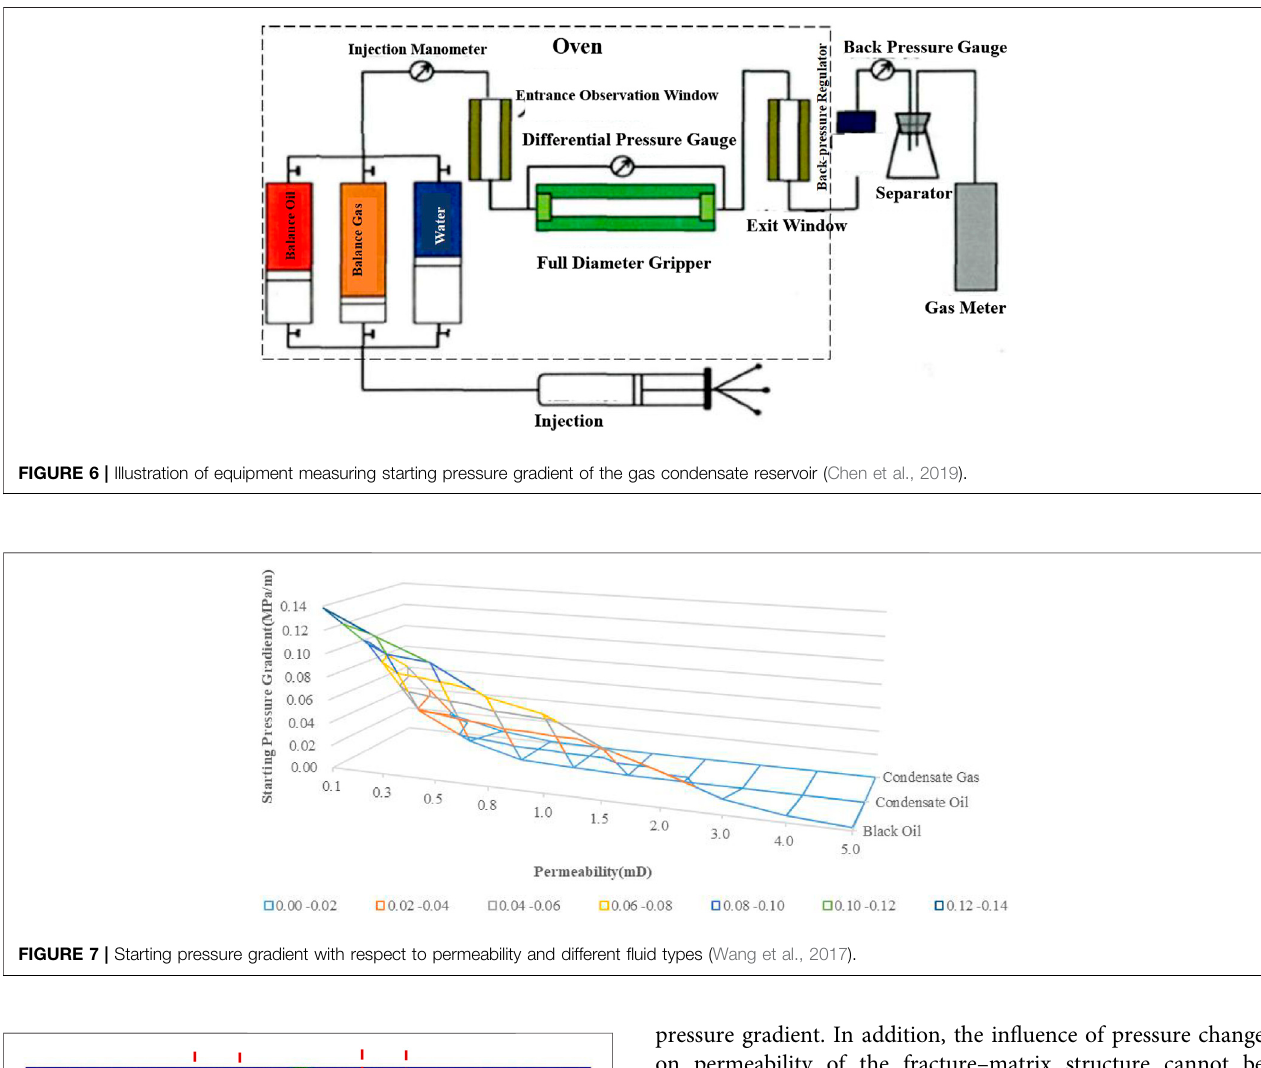
Frontiers in Earth Science |